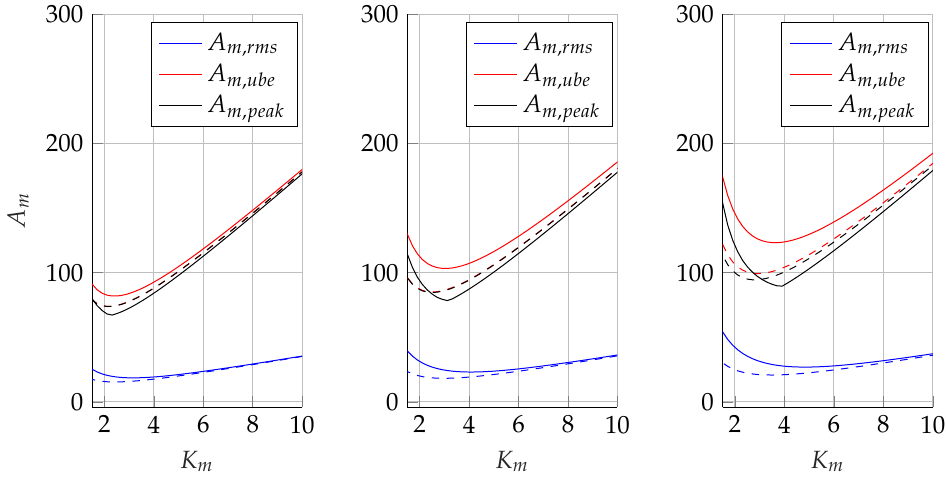
Figure 16. Load curves sensitivity analysis for axis 3 at different payloads (from left to right 0, 2 and 4 kg). Using the same color coding, the dashed lines represent an exclusively dynamic loading condition, while the continuous lines take into account also the static loads.